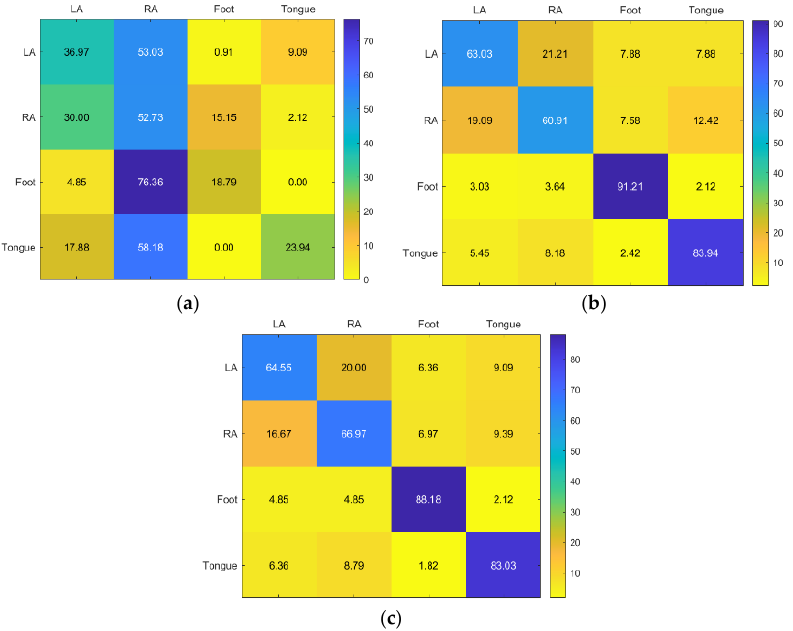
Figure 10. Confusion matrices for the ( a ) KNN, ( b ) SVM, and ( c ) RF classifiers to demonstrate the MI-BCI performance from the third subject’s four classes (left hand, right hand, feet, and tongue). For Subject 5, RF and KNN have the best accuracy, while SVM only has good accuracy for RA. However, KNN has the best accuracy for RA, while RF has the best accuracy for LA, foot, and tongue (Figure 11).